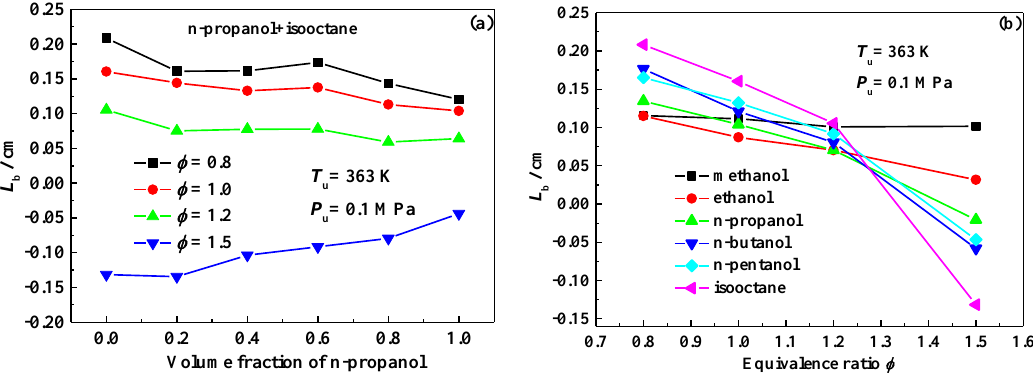
Figure 11. Markstein lengths of n -propanol-isooctane blends and pure fuels at 363 K, 0.1 MPa: ( a ) L b of n -propanol-isooctane blends; and ( b ) L b of pure isooctane and alcohol flames.